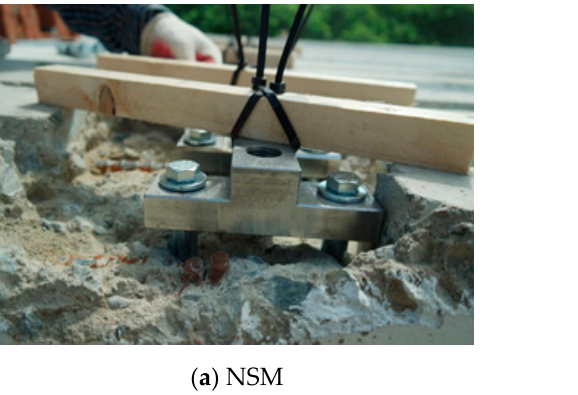
Figure 9. Load–displacement responses for different strengthening methods for a concrete strength of 20 MPa for prestressing at 140 and 280 kN.